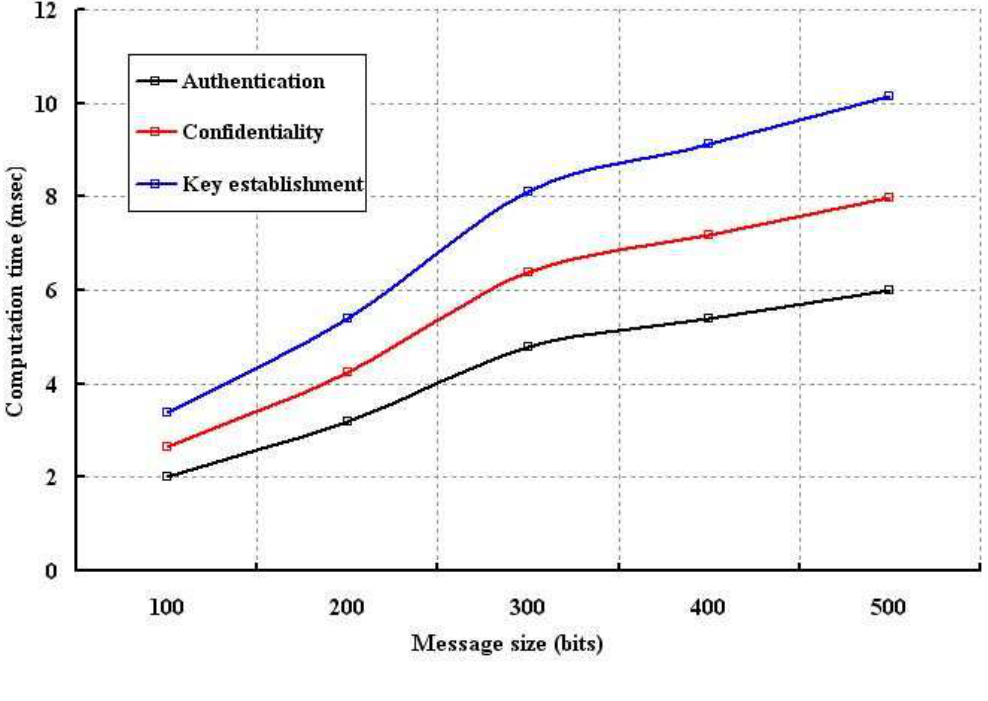
Figure 10. Evaluation of computation time with different packet size in